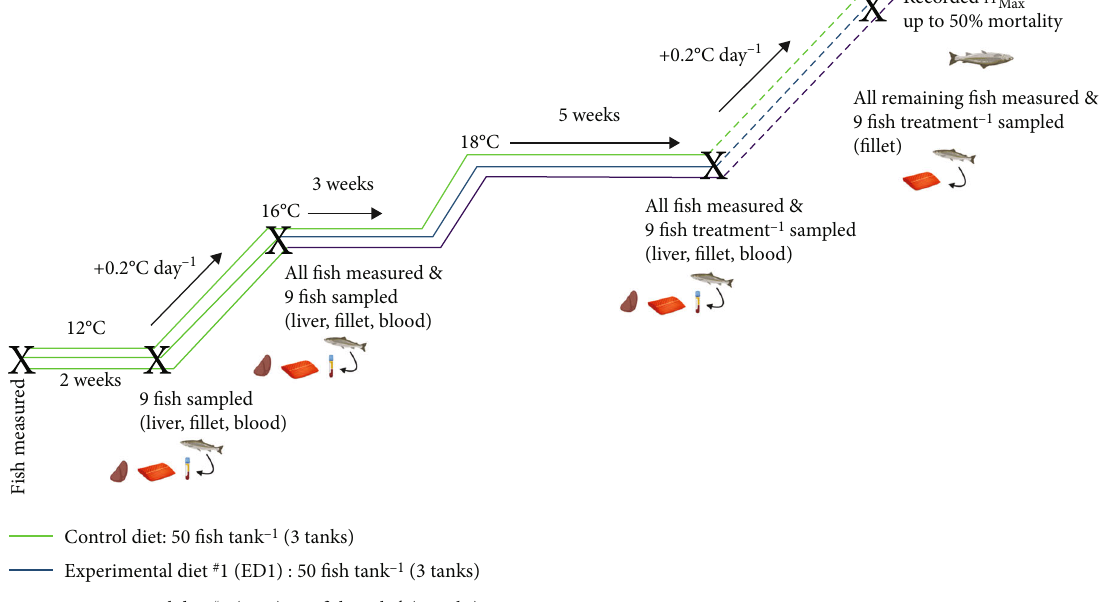
Figure 1: Overview of the protocol used to assess whether supplemental dietary cholesterol a ff ected the growth performance, physiology and survival of female triploid Atlantic salmon when exposed to an increasing temperature regimen. ‘ X ’ s mark sampling time points. Created using